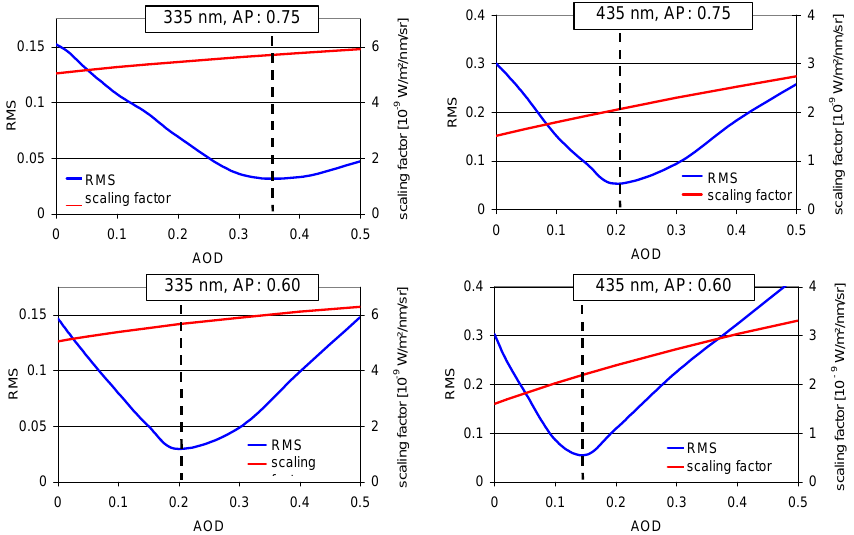
Figure 6. Scaling factors and rms derived during the fitting process (Eq. 4) as a function of the AOD for two selected scenarios and wave- lengths. The scaling factor is displayed in red (right axis), the rms in blue (left axis). In the upper panel an asymmetry parameter of 0.75, and in the lower panel one of 0.60. is used in the simulations. For both aerosol optical properties the minimum rms of the fit is found for different AOD, but the corresponding scaling factors are almost the